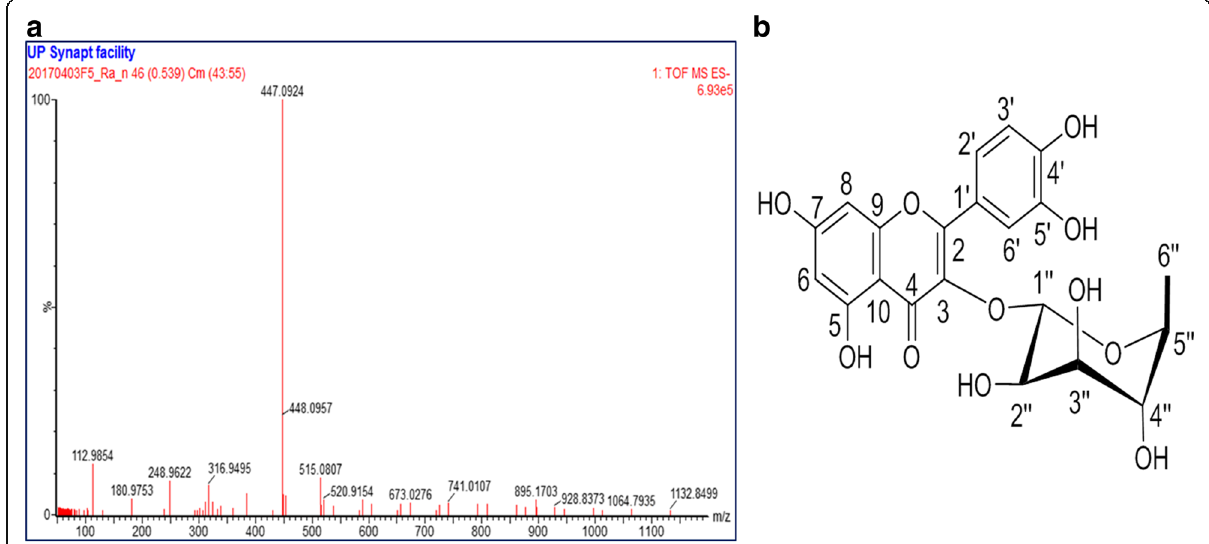
Fig. 1 ESI/MS spectrum of quercetin-3-O- α -L-rhamnopyranoside ( a ). Structure of the quercetin-3-O- α -L-rhamnopyranoside ( b )